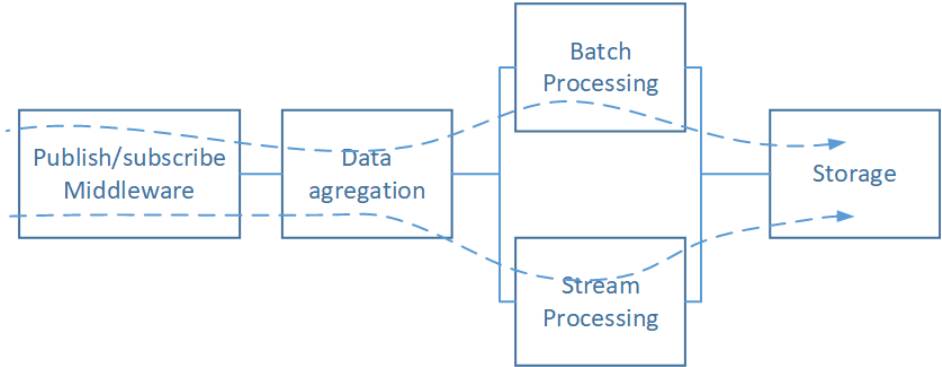
Figure 13. Lambda based architecture RBD model.